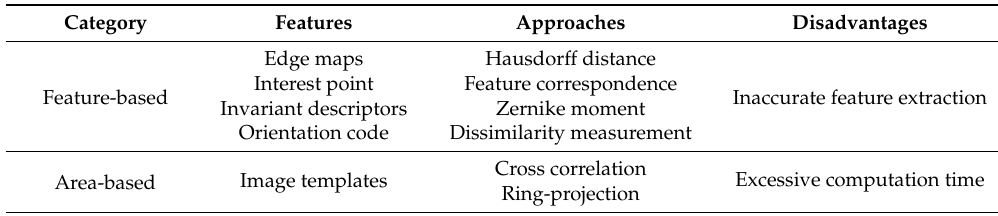
Table 1. A summary of the image alignment